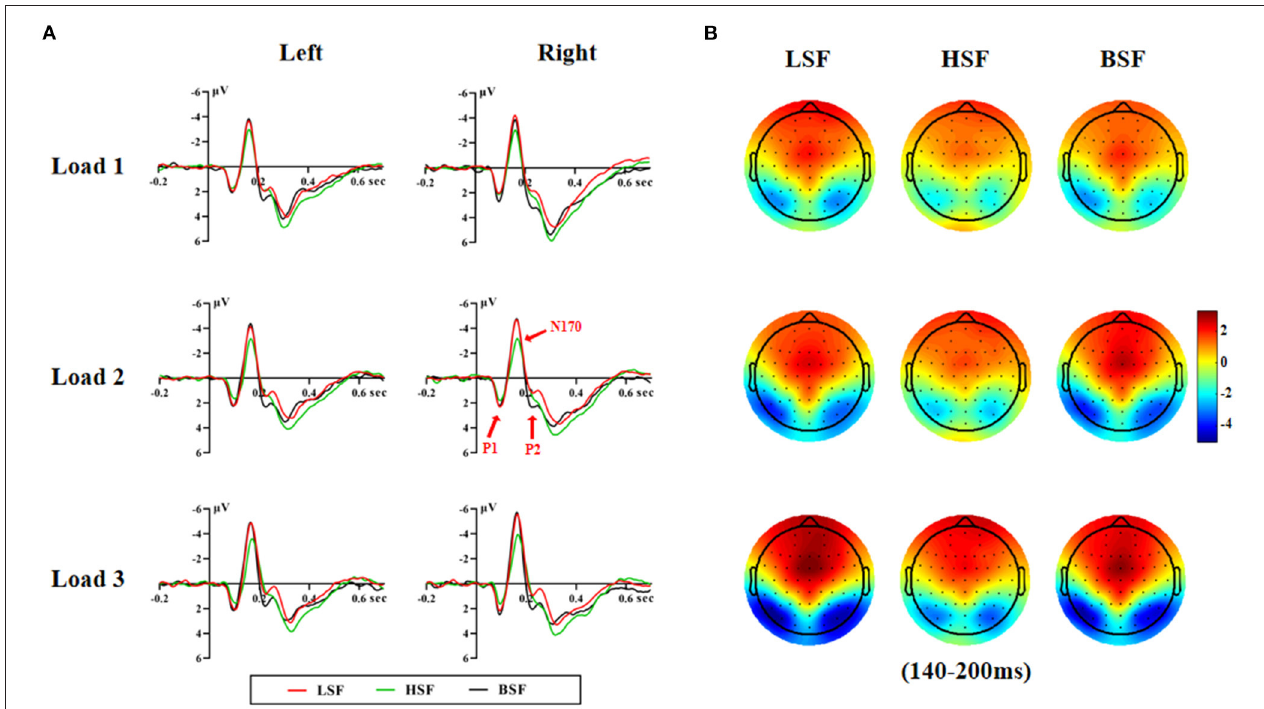
FIGURE 2 | Grand averaged ERP waveforms on the left and right hemispheres (A) and the topographic maps (B) during the encoding stage.